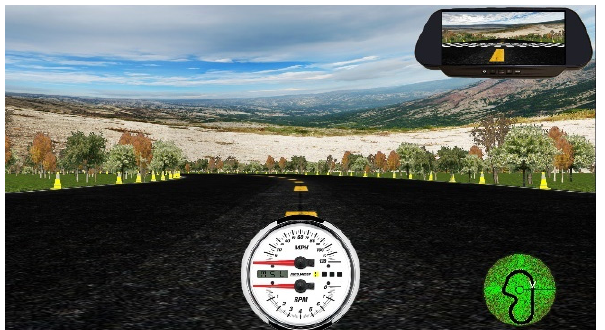
Figure 6. The tri-radial speedway scenario (CC).